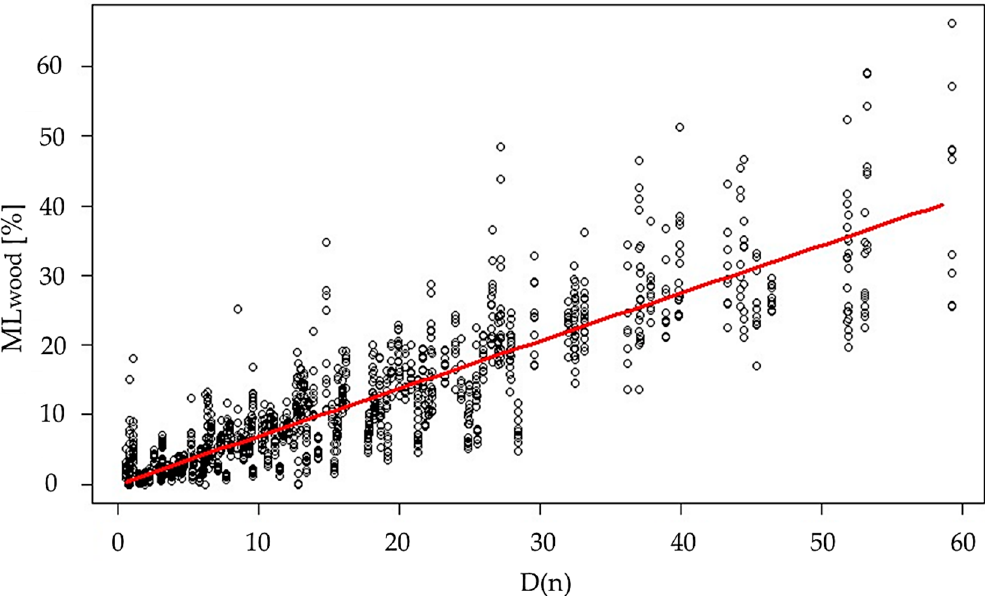
Figure 5. Relationship between dose and wood decay (ML wood ) of European beech wood specimens exposed to soil contact. Each point represents the measured ML wood of a wooden specimen incubated under certain temperature and moisture conditions after a certain exposure period. The red line is a linear function developed using maximum likelihood optimization techniques.